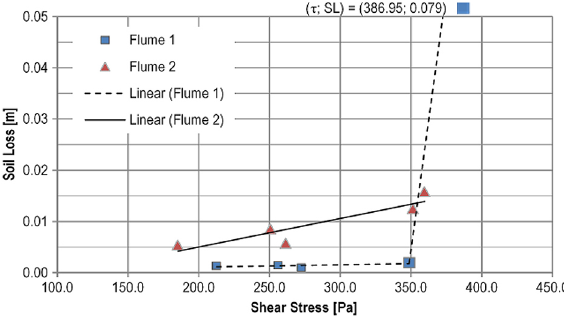
Fig. 8. Erosion rates flumes 1 & 2 (vegetated); soil loss and shear stress, steep trend line = high erosion rate, September 2014